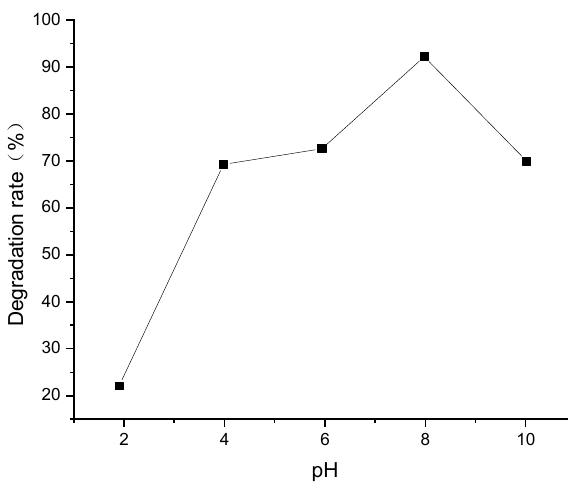
Figure 6. Degradation results of MB synthetic dye wastewater at different initial pH values.